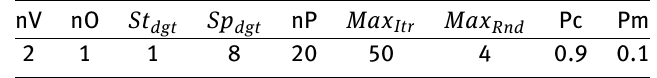
Table 29: VSSCGA Settings for Schaffer 4 function’s with 2 variables